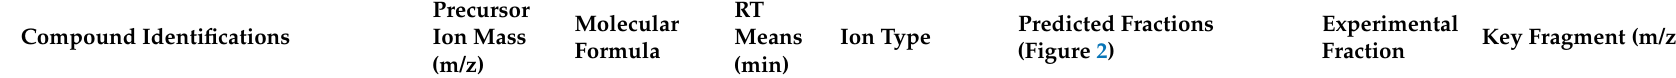
Table 1. Chemical constituents identified in the dichloromethane crude extract of the bark of O. maingayi